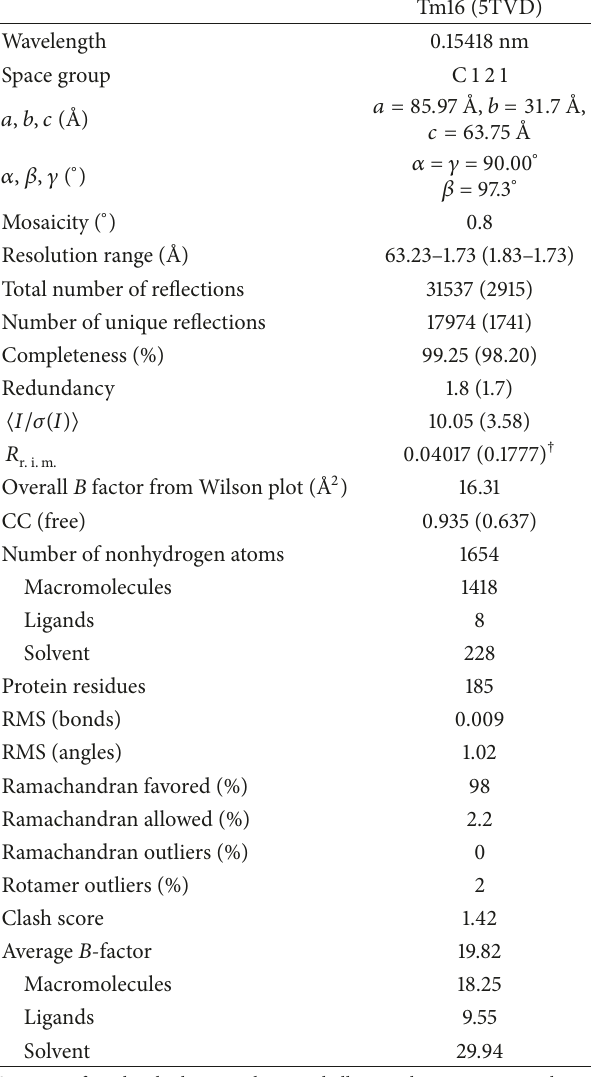
Table 1: Data collection and refinement